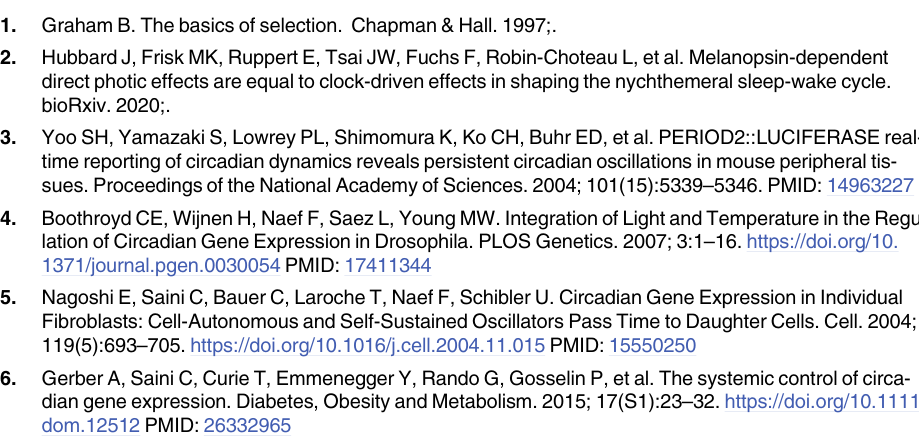
S7 Table. Linear regression slope, R2, and Kendall’s correlation test of the relationships between gene expression level and variance, standard deviation (sd), or different noise esti- mation methods. S8 Table. Welch two sample t-test comparing protein evolutionary conservation (esti- mated by the dN/dS ratio) between rhythmic and non-rhythmic genes with, or without controlling for the effect of gene expression level